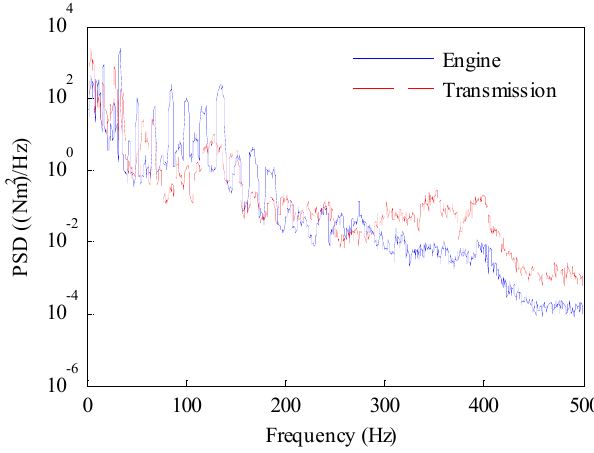
Figure 2. Power spectrum densities (PSD) of the highest speed test data.